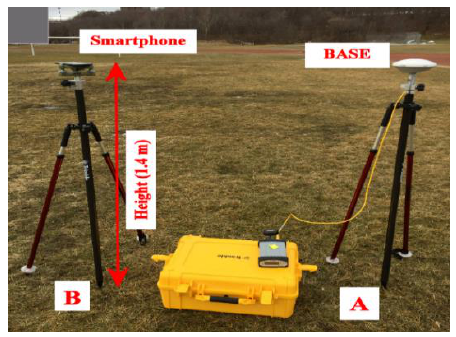
Figure 1. Setup of Trimble R9 geodetic receivers.